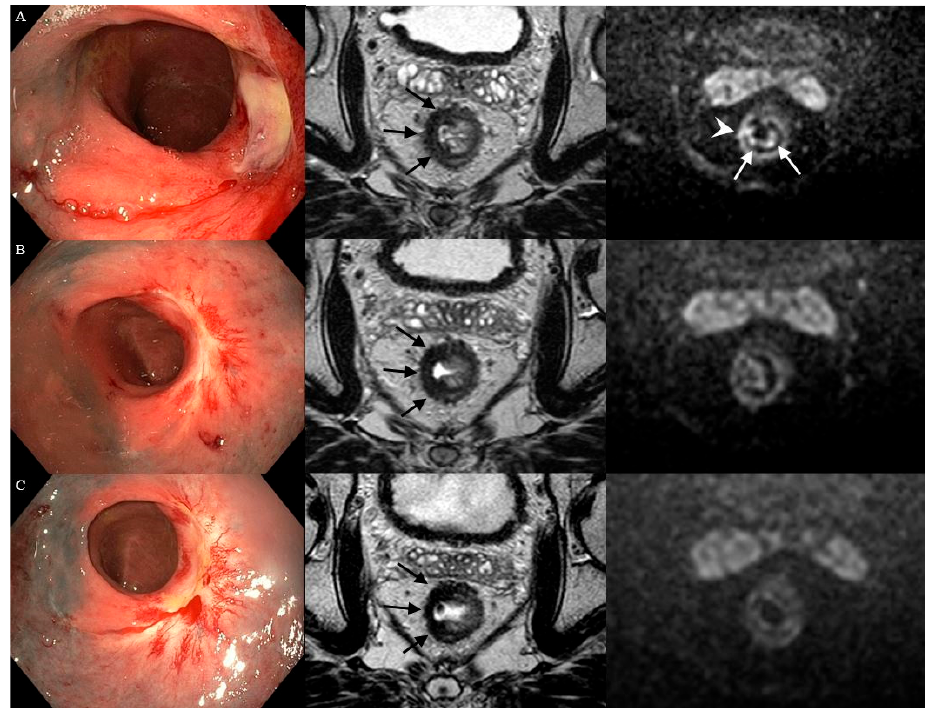
Figure 3. Case of a healing ulcer on endoscopy and the presence of a more diffuse “reactive” mucosal signal on DWI after contact X-ray brachytherapy. Three months following CXB ( A ), an irregular ulcer on endoscopy, irregular heterogeneous fibrosis (black arrows) on T2W-MRI, and small focal spots of high signal within the fibrosis (white arrowhead) in combination with a diffuse “reactive” mucosal signal on DWI were observed. Later, during follow-up at 7 ( B ) and 11 ( C ) months, the ulcer on endoscopy healed into a flat, white scar, the fibrosis on T2W-MRI became more regular and homogeneous, and, on DWI, the small focal spots and the diffuse “reactive” mucosal signal disappeared.